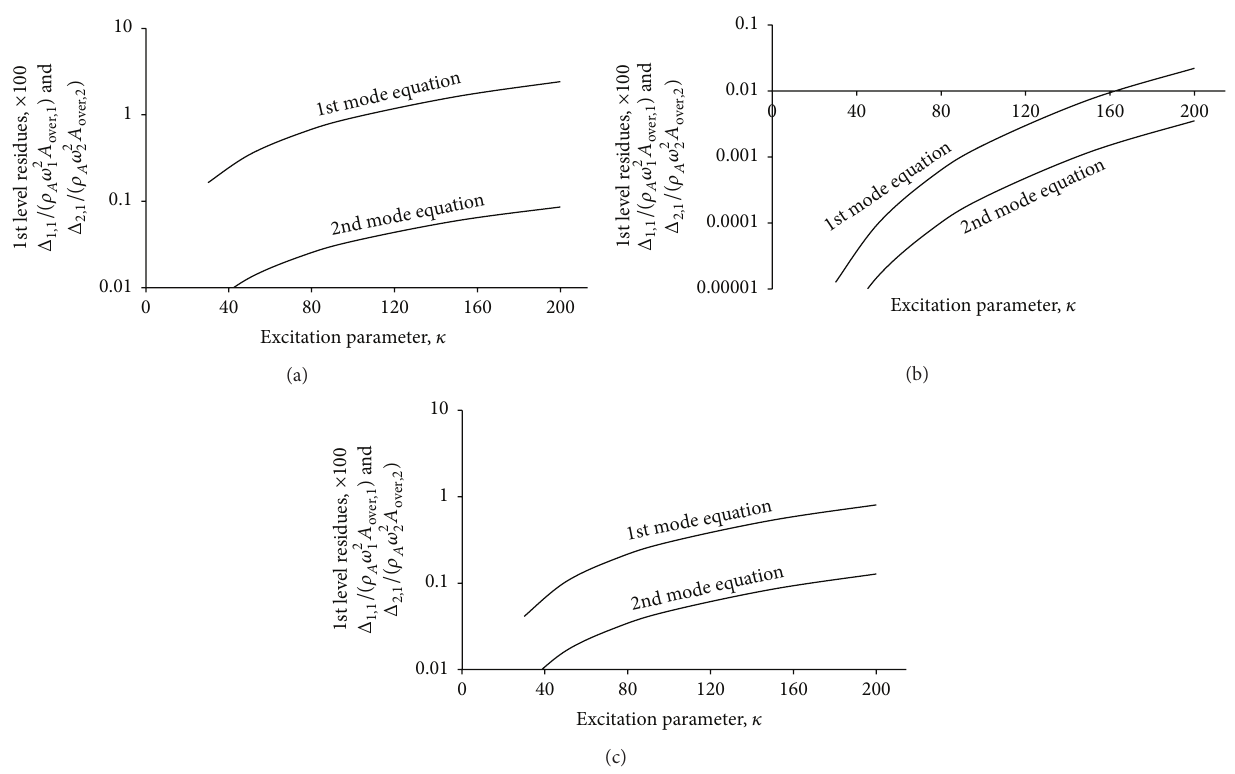
frequency is in between the two resonant frequencies) are the smallest. In general, the results have shown the converged solutions and proven the accuracy of the proposed